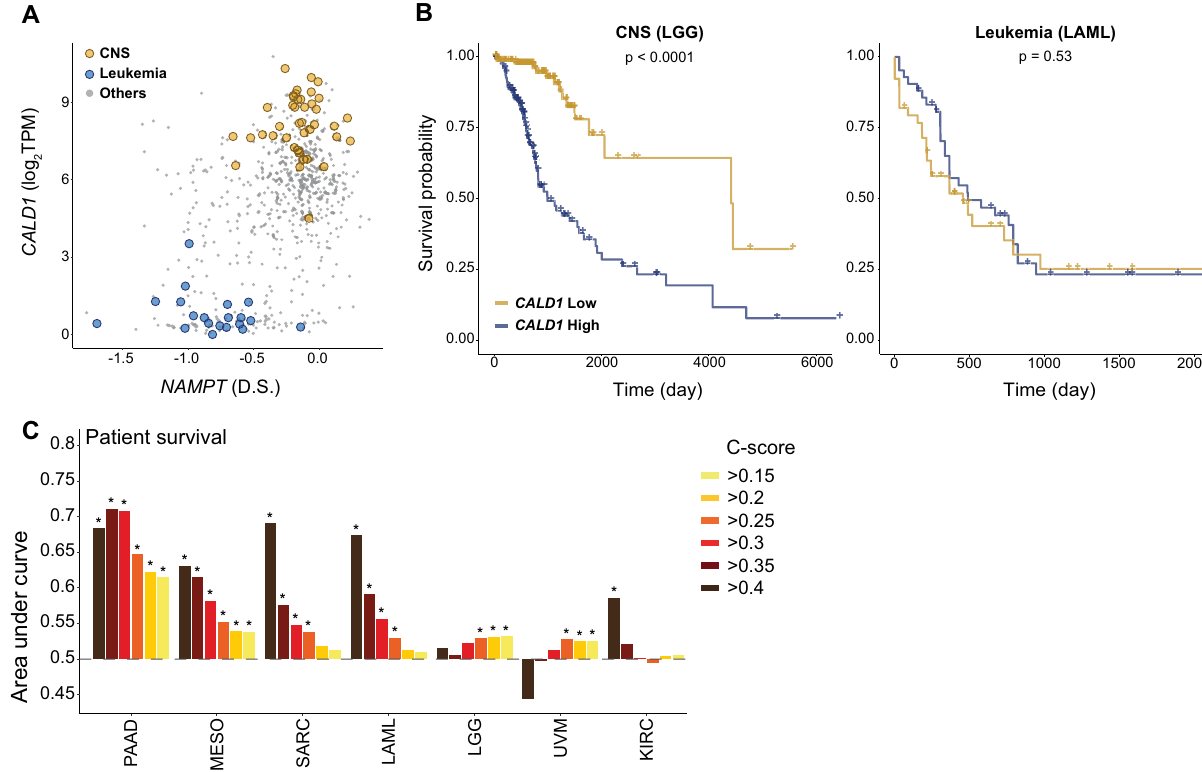
Figure 6. Harnessing cell-specific high C-score gene pairs for cancer patient prognosis. ( A ) C-score plot of NAMPT dependency score and CALD1 gene expression (C-score = 0.447). Yellow circles represent central nervous system (CNS) cell lines and blue circles denote leukemia cell lines. ( B ) Kaplan–Meier overall survival plots for CNS (LGG, lower grade glioma, left panel) and leukemia (LAML, acute myeloid leukemia, right panel) cancer patients. Patients were stratified by high (> 75%) or low (< 25%) expression of CALD1 , and p -values were calculated using Cox regression controlling for age, sex, pathological staging, clinical staging, and tumor grade, and corrected for multiple testing (FDR < 0.1). ( C ) AUC of ROC curves based on C-score gene pair-based prediction of survival for each cancer type with different C-score cutoffs. Only the cancer types with at least one significantly positive C-score cutoff and those containing more than 50 positive genes predicting patient survival with statistical significance are shown (*denotes p <